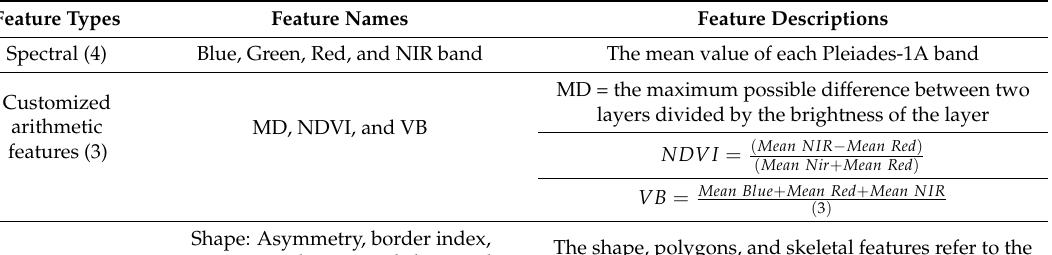
Table 2. List of image object